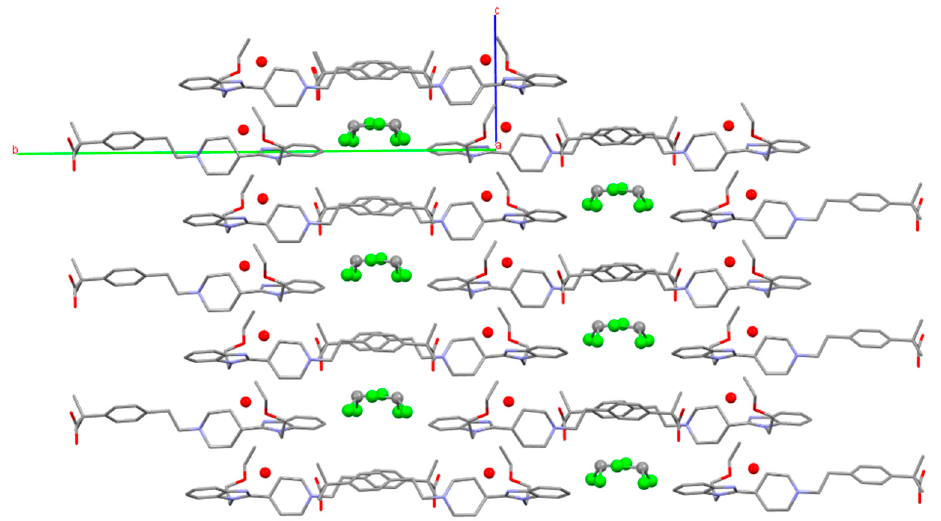
Figure 23. Crystal packing of form S CHCl3-H2O viewed parallel to [100]. Water molecules represented by red balls. Hydrogens have been omitted for clarity.